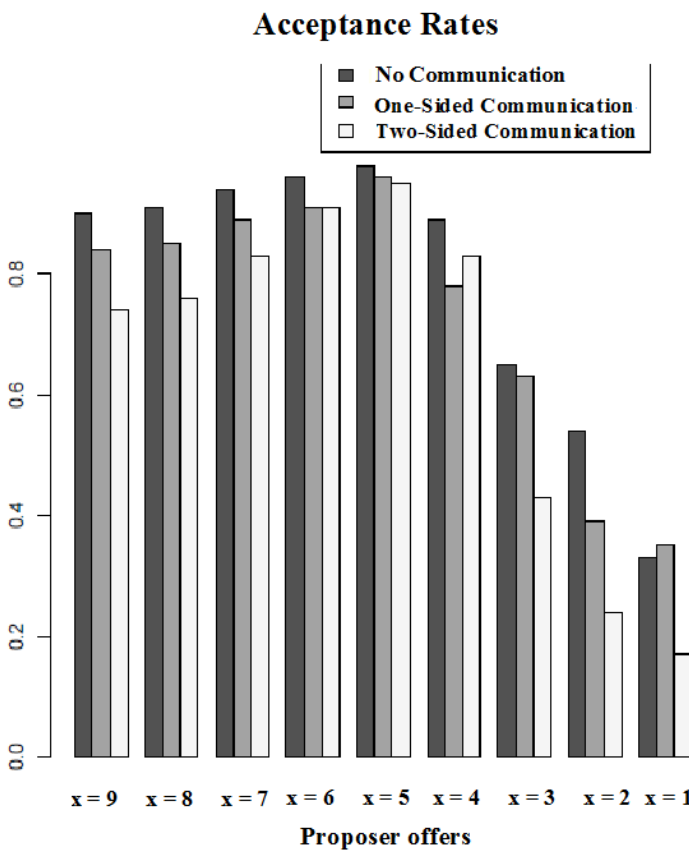
Figure 2. Conditional choices of Y (comparison across